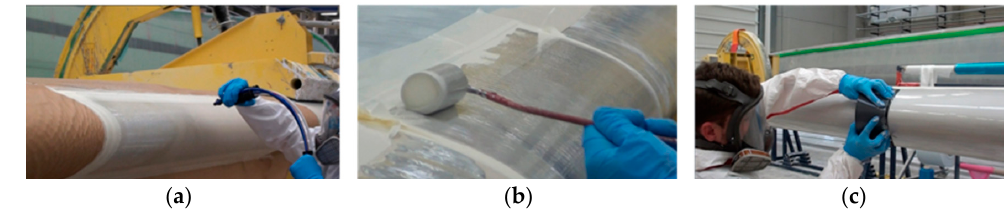
Figure 5. Leading edge protection application procedures, i.e., ( a ) spray; ( b ) roller; ( c ) trowel.